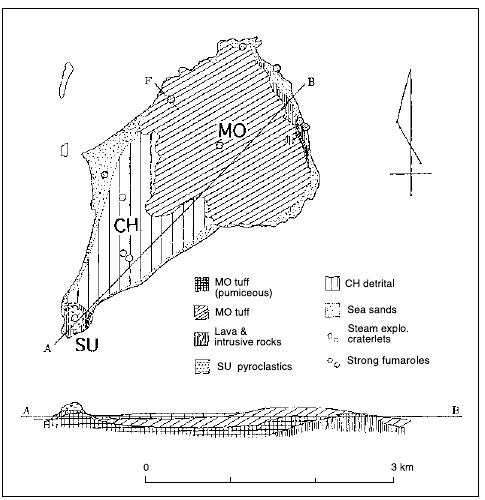
Fig. 6. Geologic sketch map of Iwojima (after Morimoto et al. ,